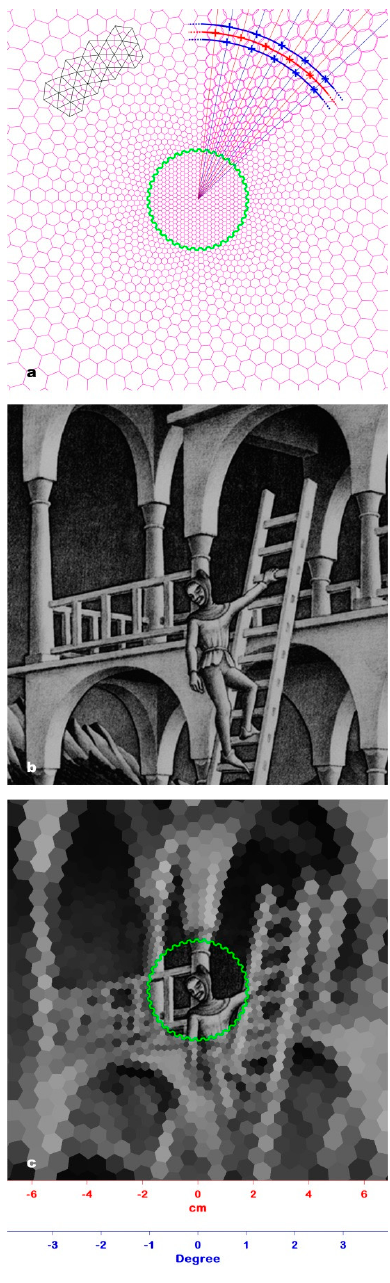
Figure 2. ( a ) Log-polar triangular lattice of the RFs in the retina model. The right upper part shows the building elements of the model: rays (blue lines) and rings (thick blue and red lines). The intersections between the rays and the rings mark the centers of the RFs (asterisks). RFs’ overlapping is minimized by replacing circular RFs with the corresponding inscribed irregular hexagons. The lattice triangles result from the joining of RF centers placed on successive rings (left upper part, black line). The serrated green line marks the border between the central zone and the peripheral zone. For the sake of clarity, N is set to 40. ( b ) Detail of the Belvedere lithograph chosen to test the retina model. ( c ) The pre-attentive retina image (PRI) of the Belvedere detail shown in Figure 2b. The serrated green line marks the border between the central zone and the peripheral zone.